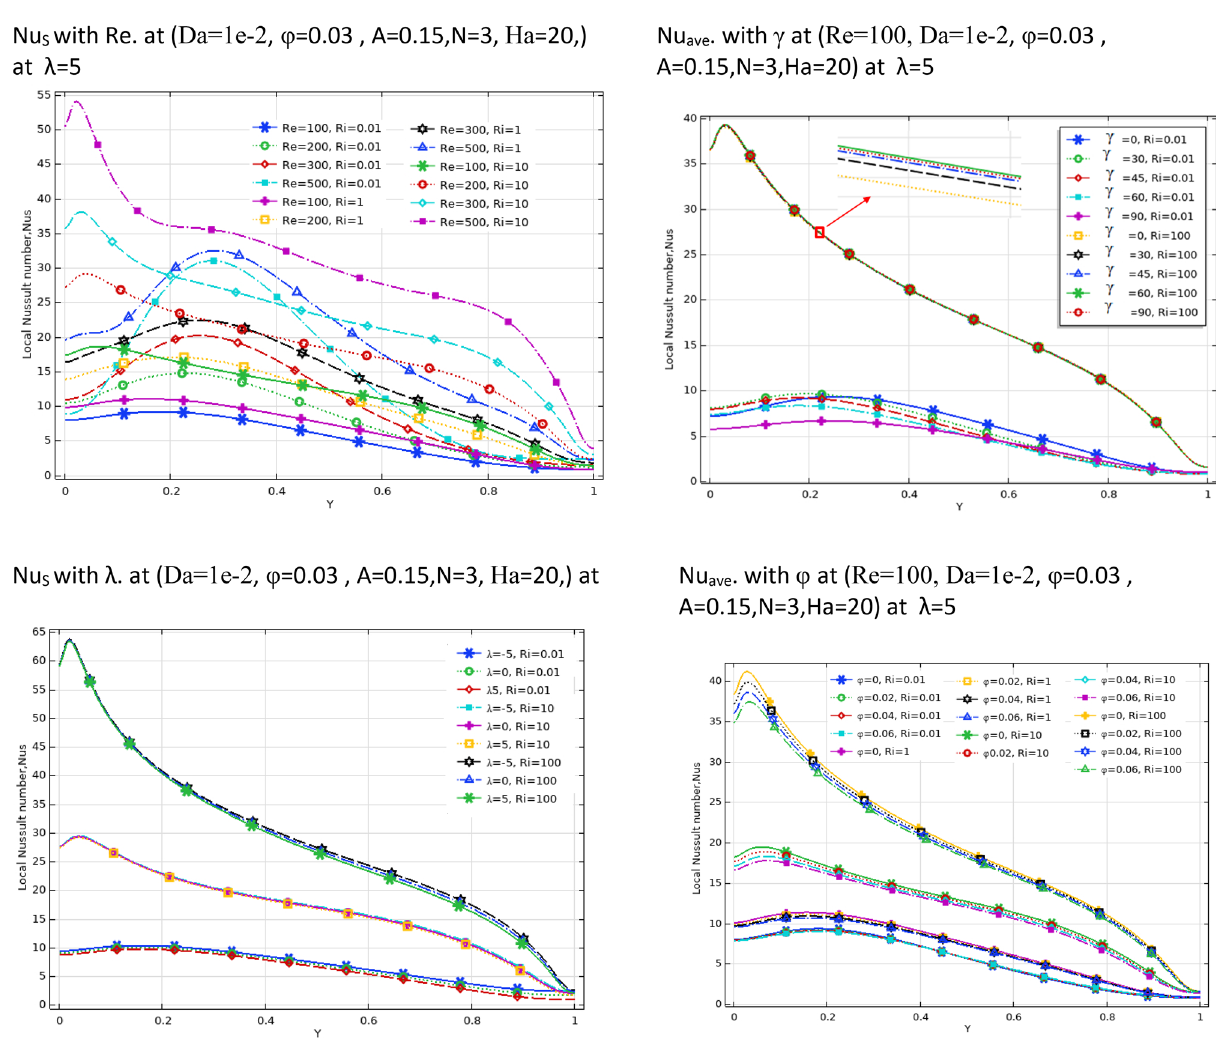
Figure 9. Local Nusselt number for different parameters as variable for Case